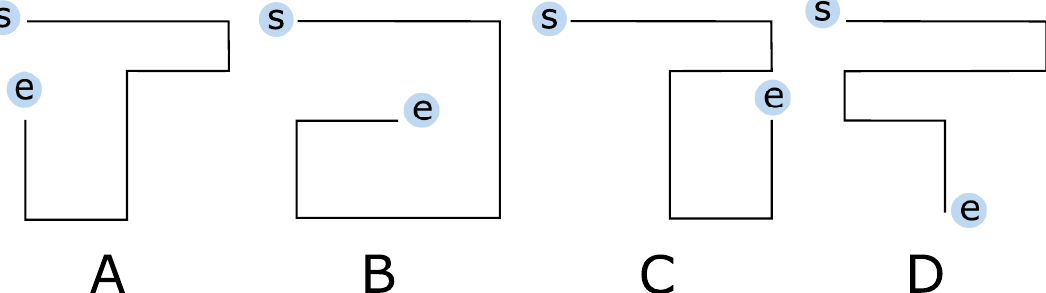
Figure 8. The four pathways ( A – D ) used in the third experiment. Haptic guidance started at point s and ended at point e .